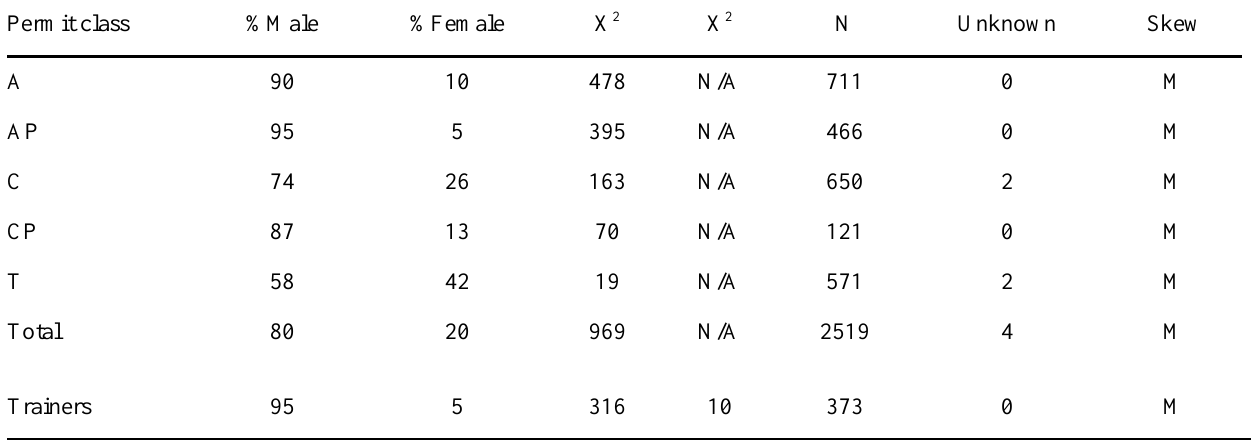
Table 4 . The percentage of participants in the BTO Ringing Scheme by permit class. The chi-square statistics computed for each permit class were greater than the critical value at P = 0.05. Classes AP and CP are for those near retirement age in permit classes A and C, respectively (data on Trainers from Spence 2007). Permit